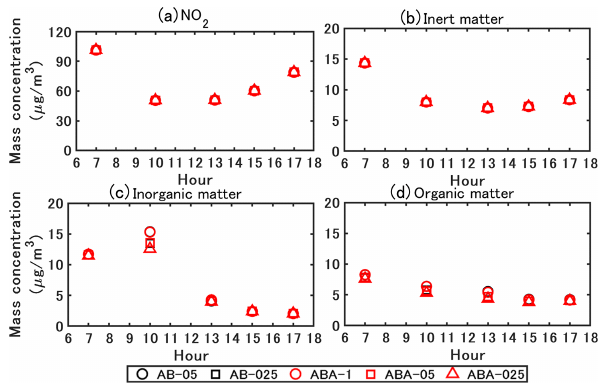
Figure 9. Simulated NO 2 and particle concentrations with different grid resolutions. Figure 10. Simulated NO 2 and particle concentrations with